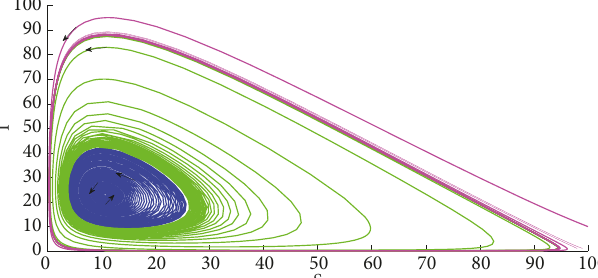
Figure 6: Phase portrait of the system when there are two limit cycles: the outer one is stable and the inner one is unstable.